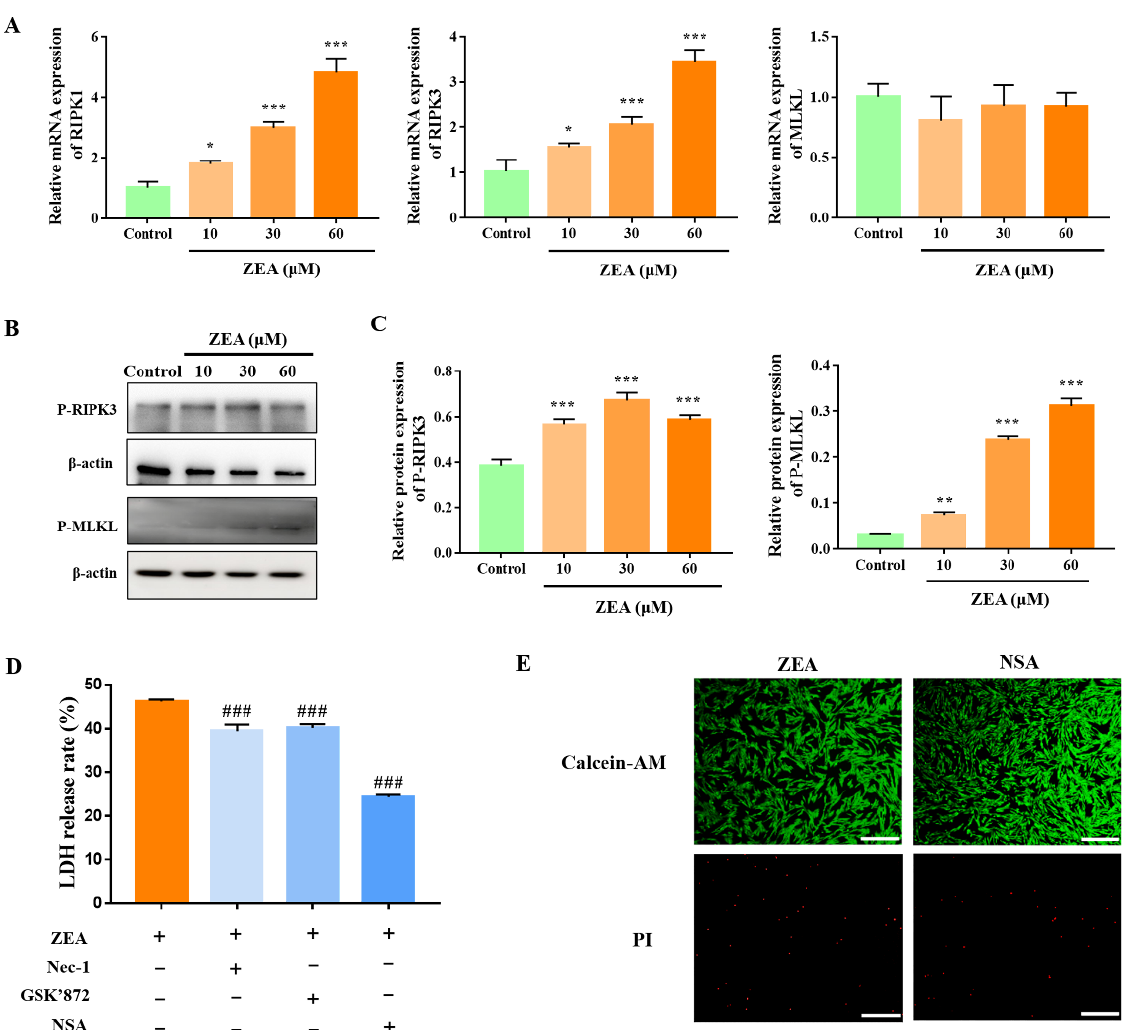
Figure 2. ZEA induces MLKL-mediated necroptosis in gESCs. A-B Cells were treated with different concentrations (10, 30, and 60 µ M) of ZEA for 24 h. ( A ) RT-qPCR analysis of the mRNA levels of necroptosis-related proteins. ( B ) Western blot analysis of the expressions of P-RIPK3 and P-MLKL proteins. ( C ) Quantification of P-RIPK3 and P-MLKL expression, with β -actin as an internal control. ( D ) Cells were pretreated with the RIPK1 inhibitor Nec-1 (10 µ M), RIPK1 inhibitor GSK’872 (5 µ M), or MLKL inhibitor NSA (2.5 µ M) for 2 h before treatment with 60 µ M ZEA for 24 h. LDH release was evaluated using a cytotoxicity LDH assay kit. ( E ) Cells were pretreated with NSA for 2 h before treatment with ZEA for 24 h. Cell death was detected by Calcein-AM/PI staining. Scale bar, 100 µ m. * p < 0.05, ** p < 0.01, *** p < 0.001 vs. control group. ### p < 0.001 vs. ZEA group.